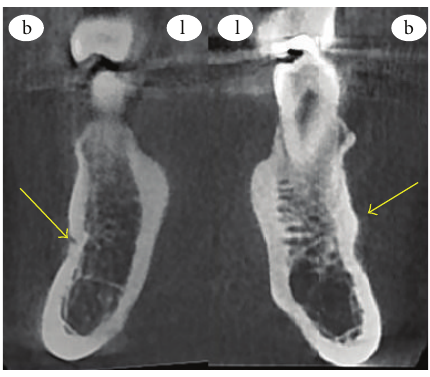
Figure2:CoronalCBCTsliceinwhichtheopeningsoftherightMF and the left protuberance at the MF area are pointed by the arrows.